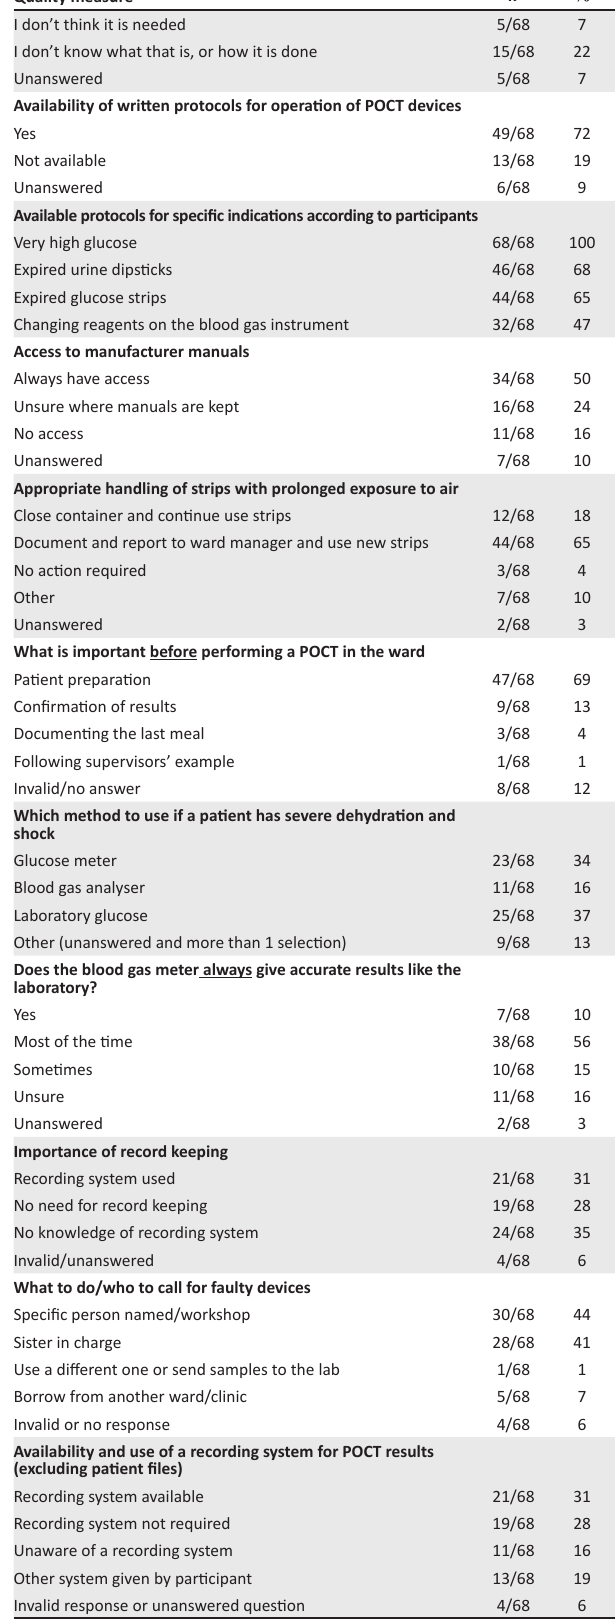
TABLE 2: Awareness and knowledge of point-of-care best practices amongst healthcare workers at Tygerberg Hospital, Cape Town, South Africa, June-July 2016.